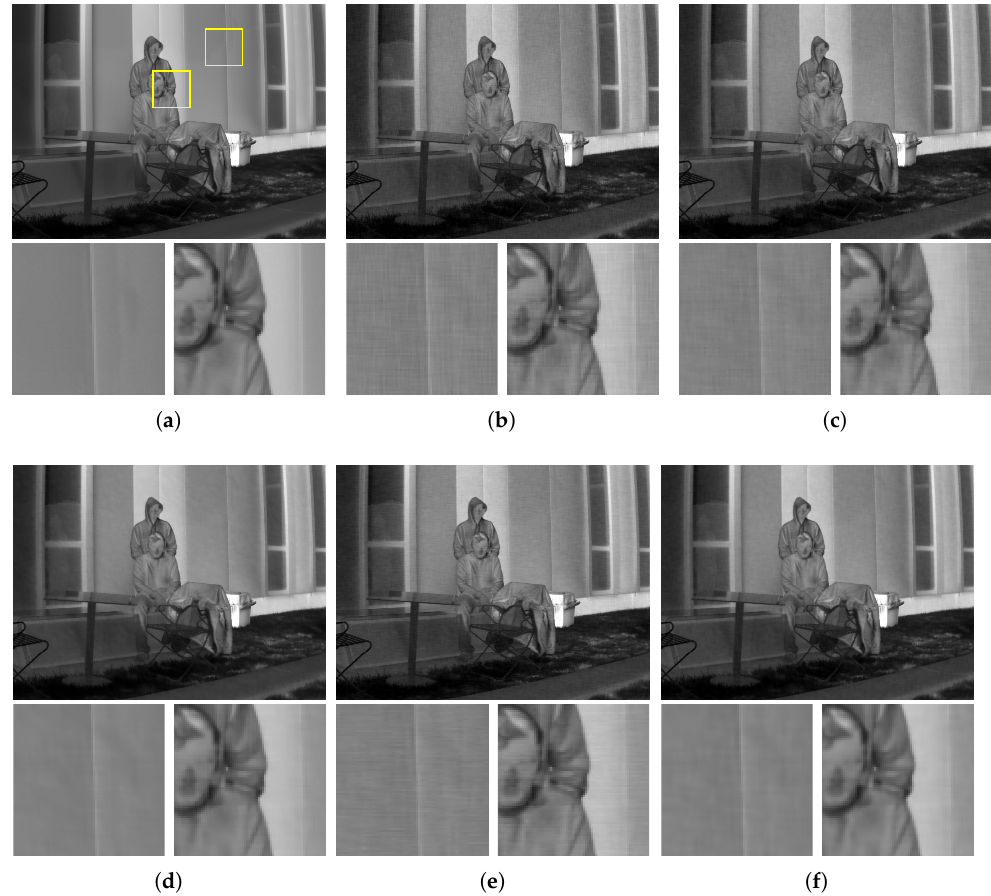
Figure 9. Results from the experiment of RNU. Regions marked with rectangles are magnified. The cost functions incorporating our hypothesis demonstrate more clear output images. ( a ) Original image; ( b ) degraded image; ( c ) result with Equation (24); ( d ) result with Equation (25); ( e ) result with Equation (26); ( f ) result with Equation